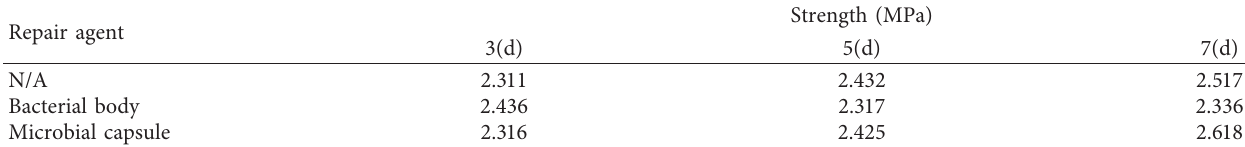
Table 7: Comparison of compression strength under various curing